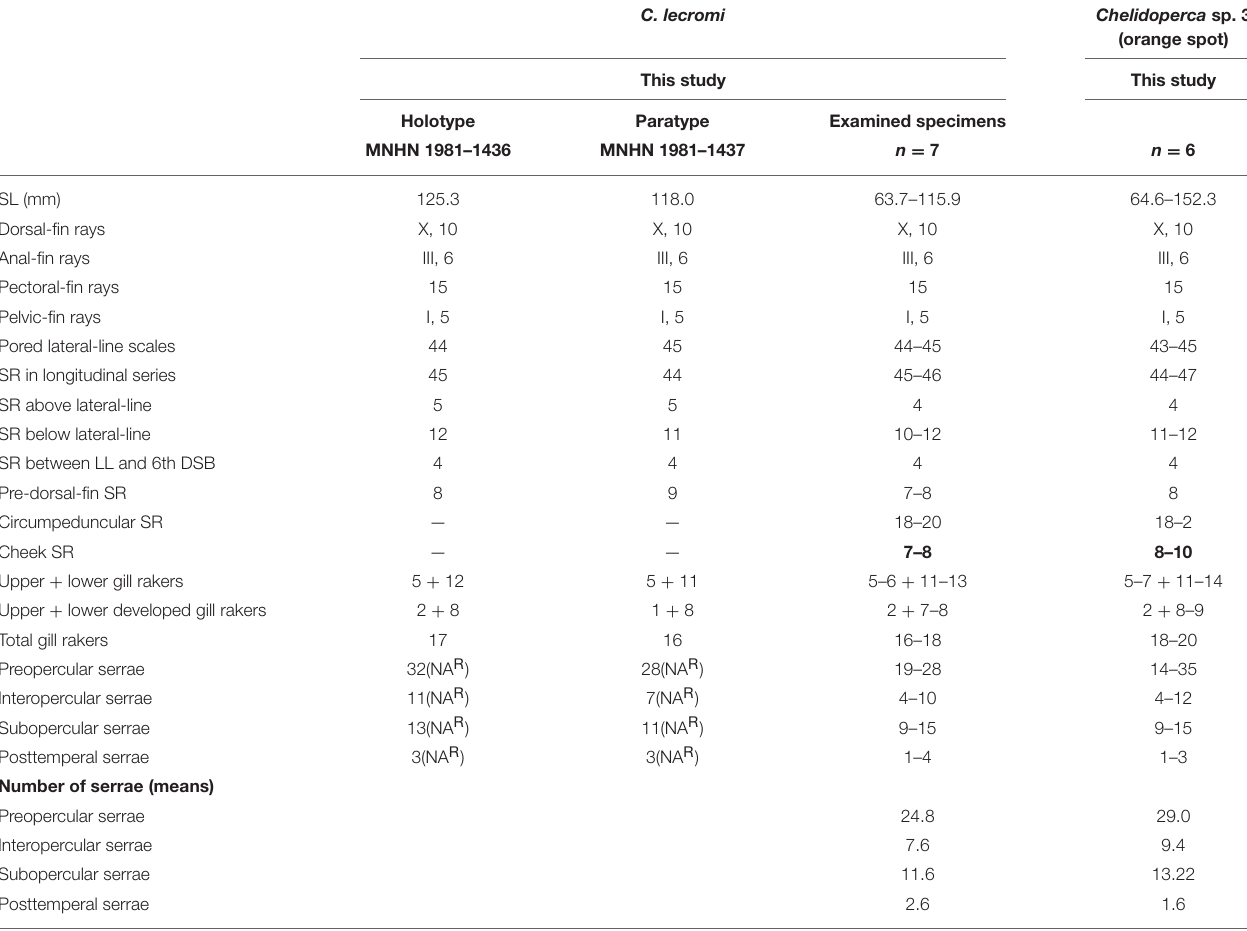
TABLE 4 | Meristic features of Chelidoperca lecromi (including examined specimens and references data) and Chelidoperca sp. 3 (orange spot); bold font presents distinguishing